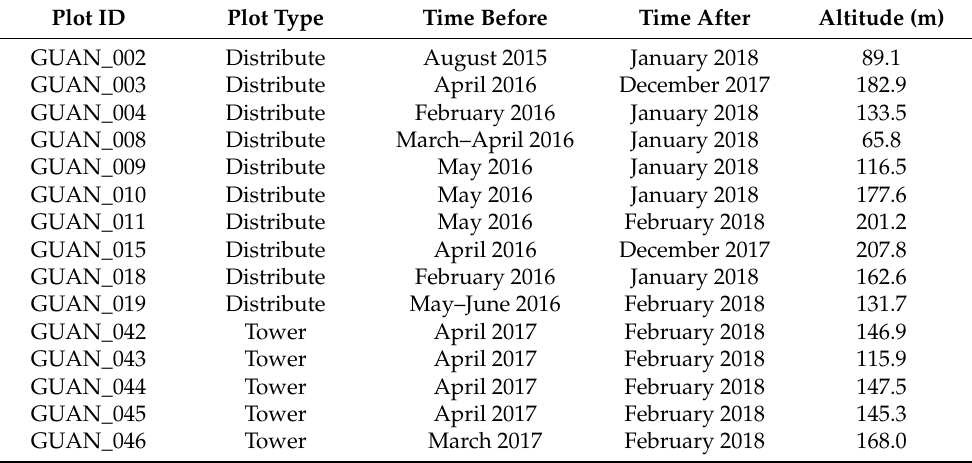
Table 1. The 15 plots used for vegetation structural change assessment before and after the